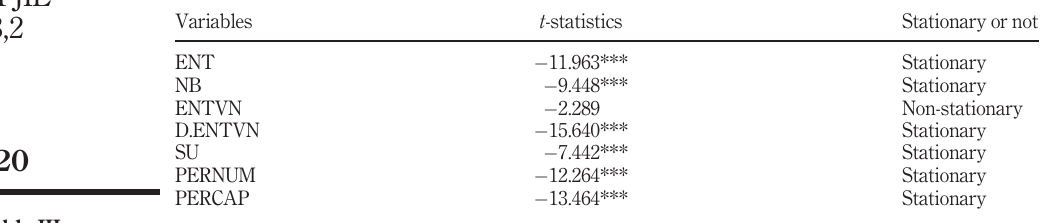
Table III. The test of stationary by Phillips and Perron (1988)